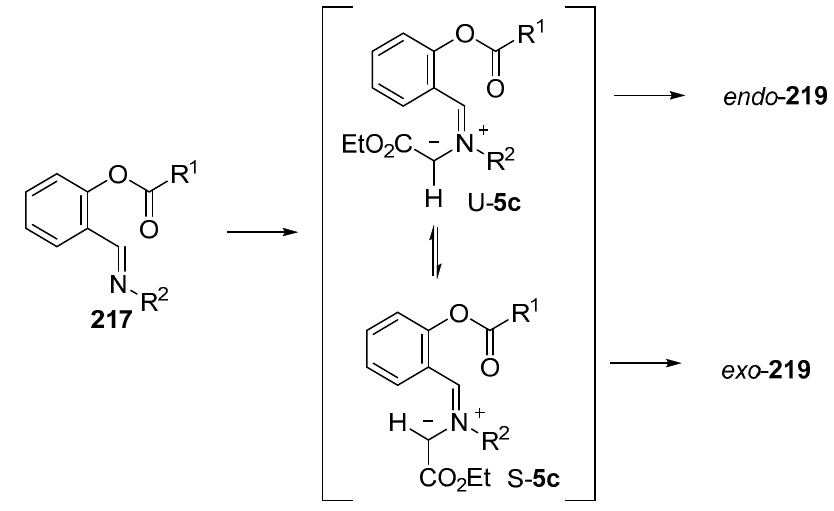
Table 29. Reaction of imines 217 , ethyl diazoacetate ( 218 ) and Cu(tfacac) 2 in CH 2 Cl 2 at 40 °C (Scheme 61).